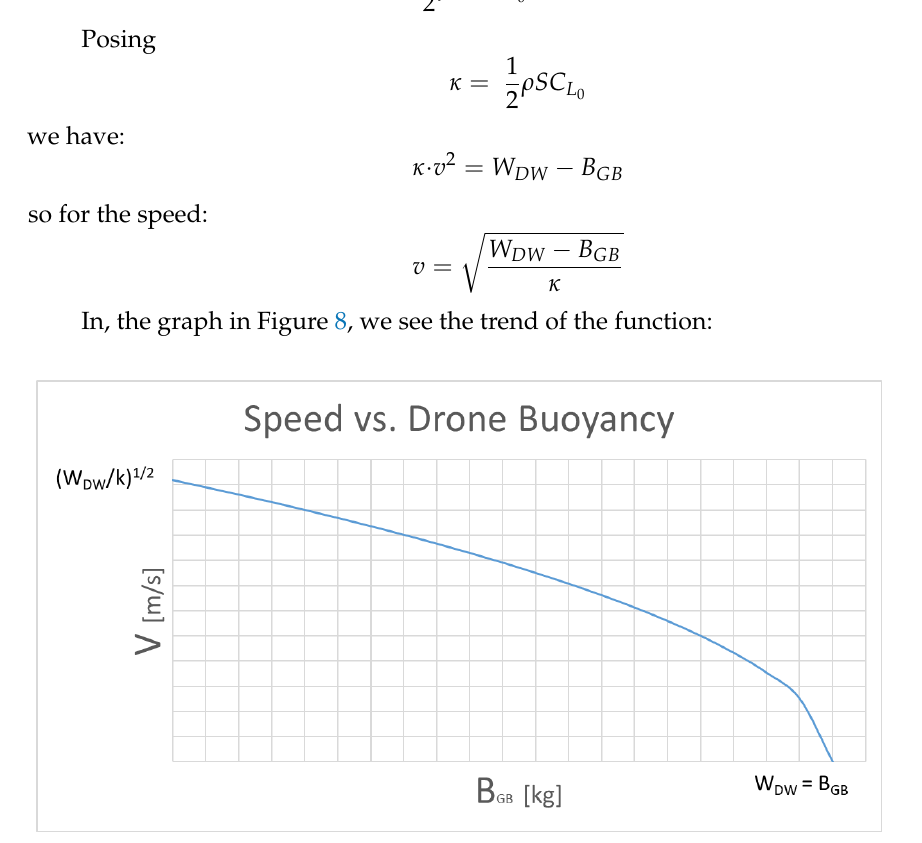
Figure 8. Qualitative trend of the function Speed vs. drone buoyancy.